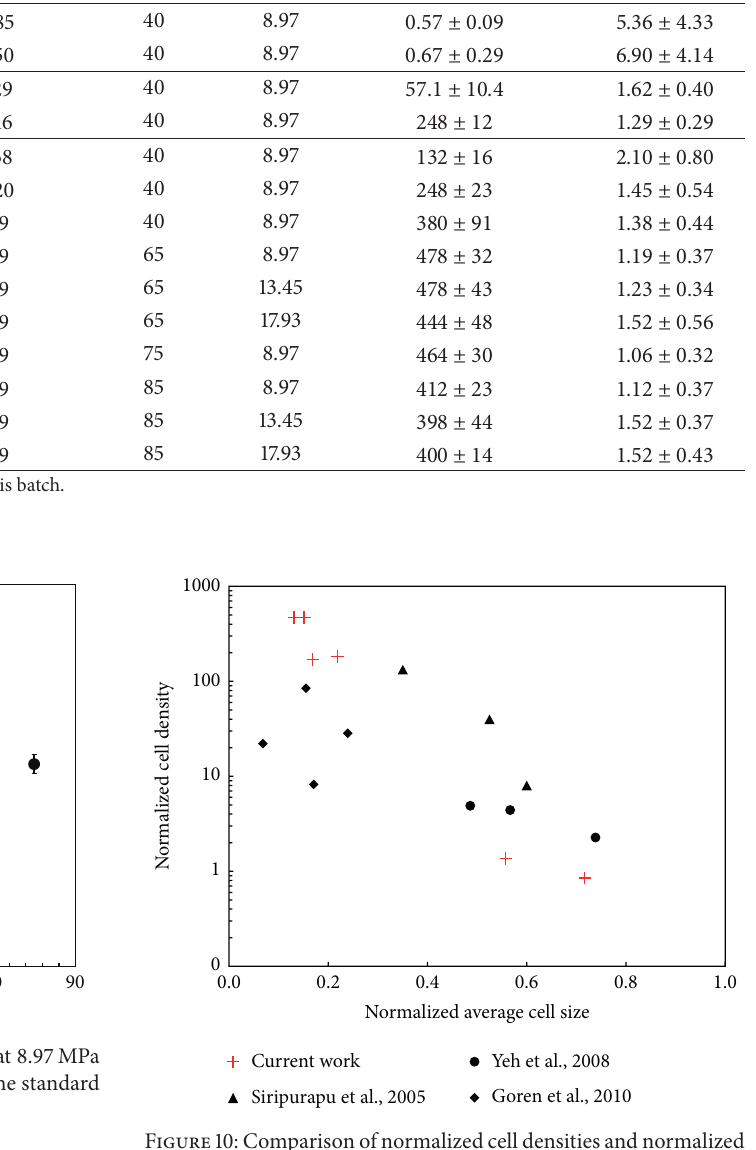
Figure 10: Comparison of normalized cell densities and normalized average cell sizes of various silica/PMMA nanocomposite